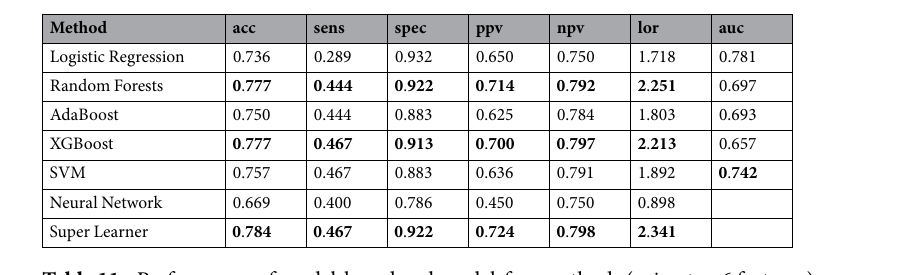
Table 11. Performance of model-based and model-free methods (using top 6 features).